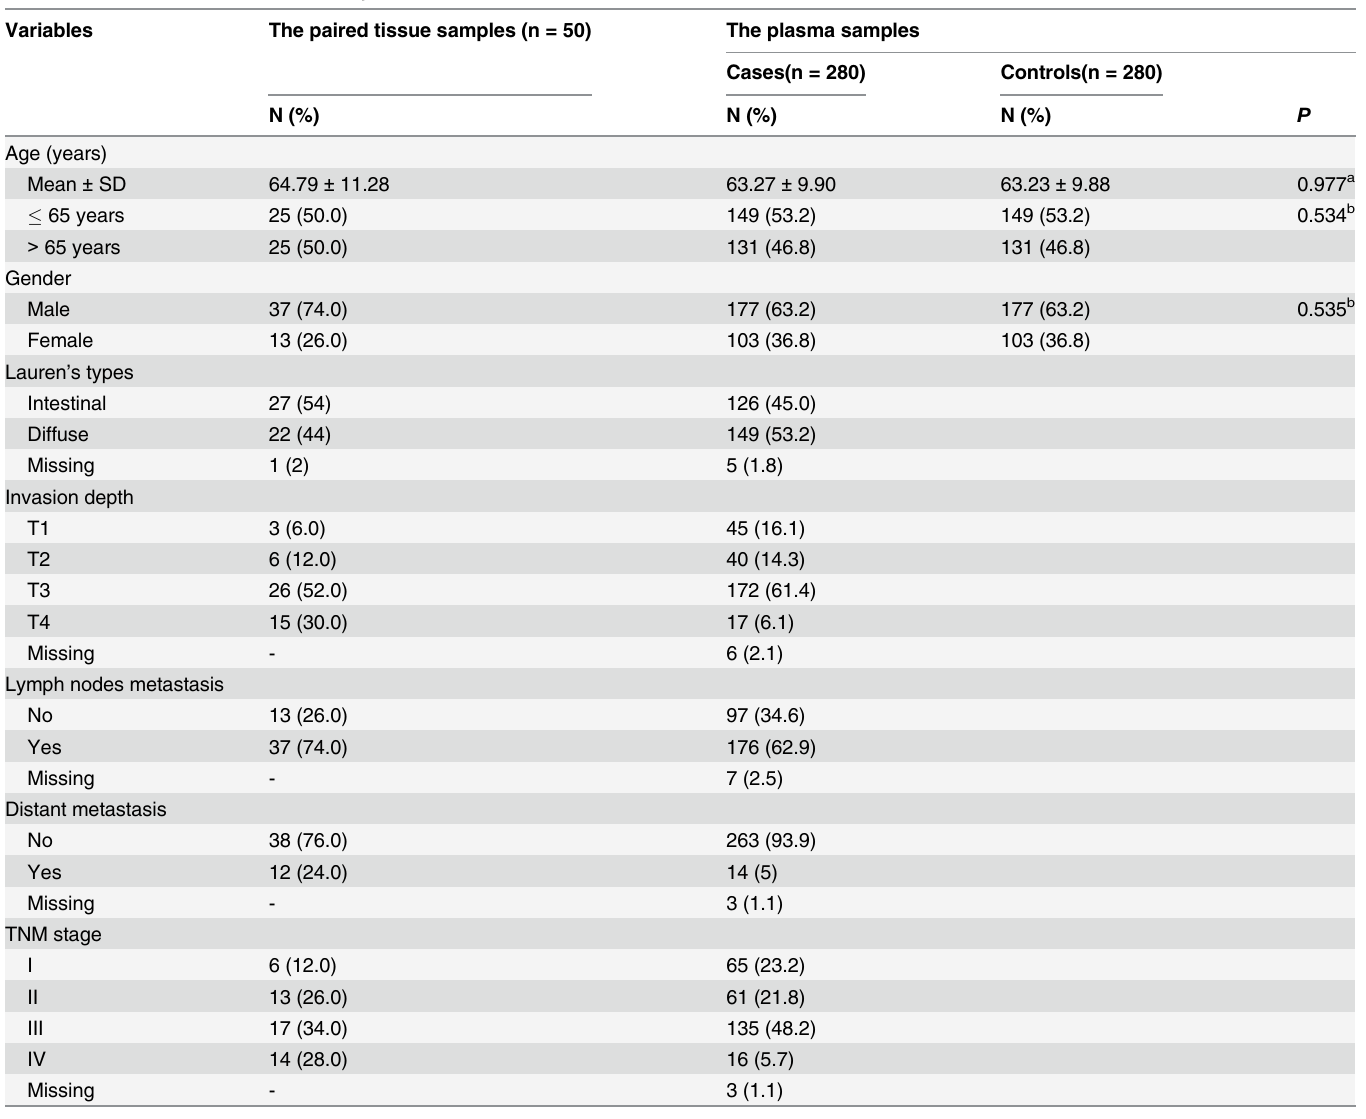
Table 1. Clinical characteristics of subjects.